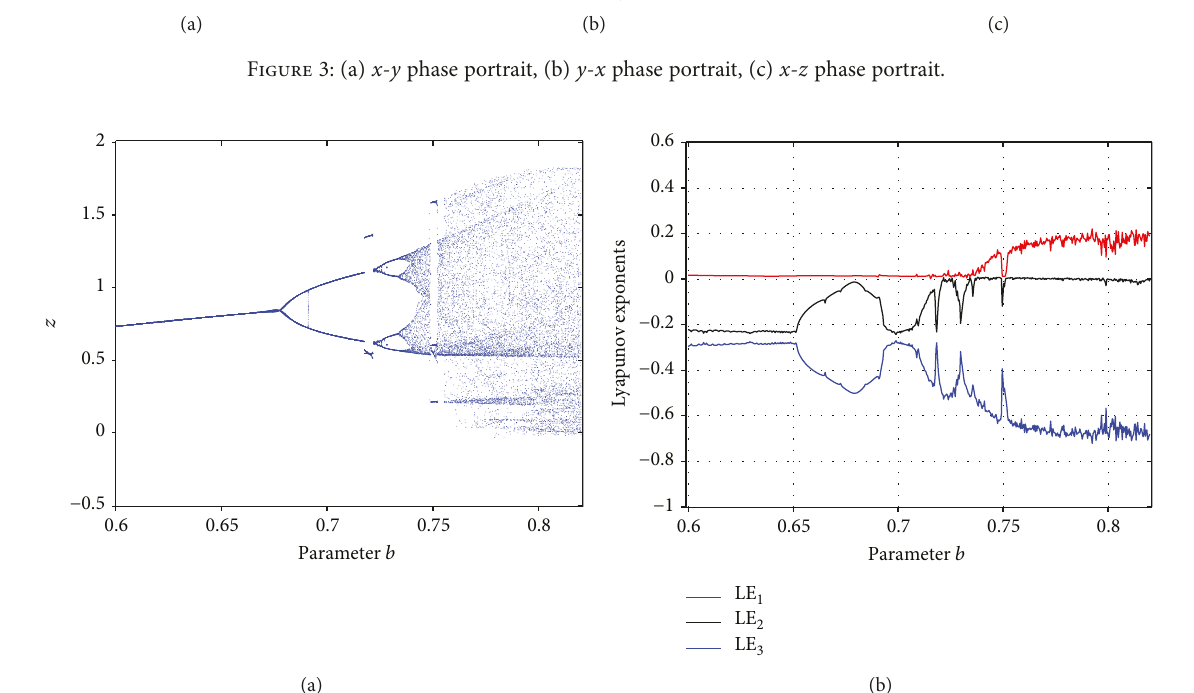
Figure 4: (a) Bifurcation diagram and (b) Lyapunov exponent spectrum versus parameter b .